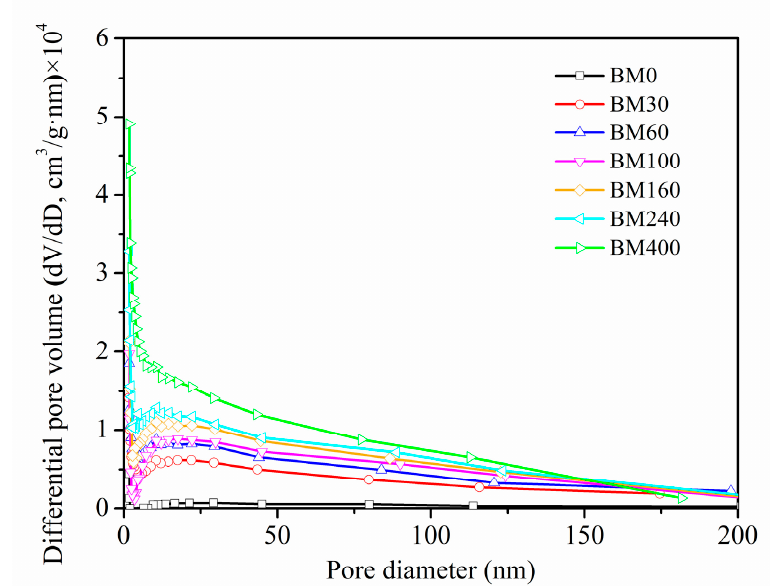
Figure 4. Pore size distribution of PIDF at different scales.